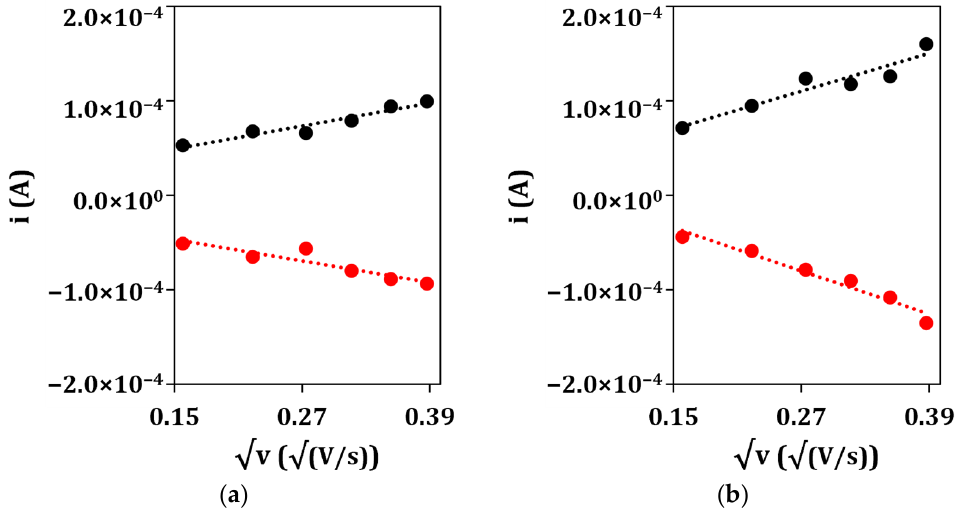
Figure 3. Plots of anodic (•) and cathodic (•) peak currents vs. the square root of the scan rate for ( a ) bare GSPE and ( b ) (Au&Ag)NPs/GSPE. The electroactive area values obtained for both platforms are reported in Table 2. Table 2. Electroactive ‐ area values of unmodified GSPEs and (Au&Ag)NPs/GSPEs, as calculated from the cyclic voltammograms performed in [Fe(CN) 6 ] − 4/ − 3 redox probe.